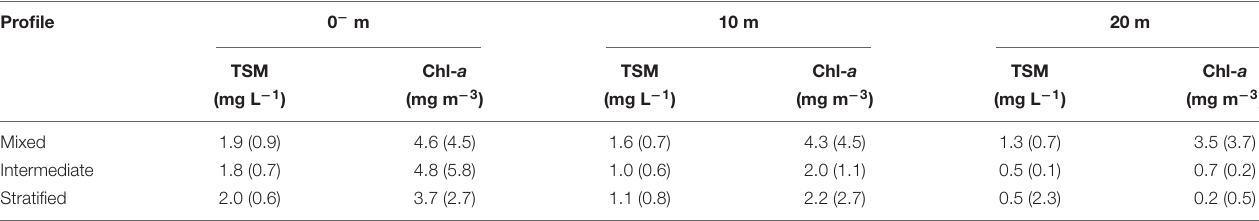
TABLE 3 | In situ measured optically significant constituents (OSC), such as the concentration of total suspended matter (TSM) and chlorophyll -a (Chl- a ) for different hydrodynamic situations at different